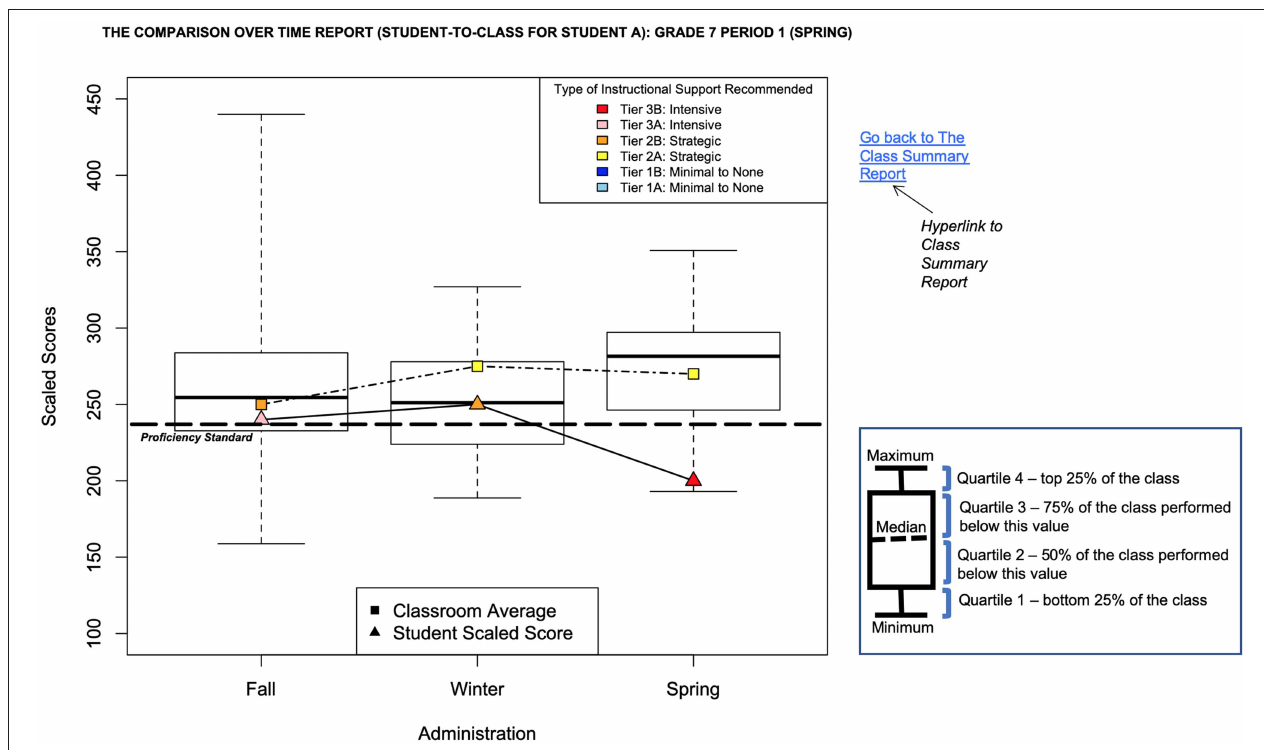
FIGURE 4 | Suggested modifications to The Comparison Over Time Report using proposed solutions for the roadblocks encountered by teachers and literature on effective report